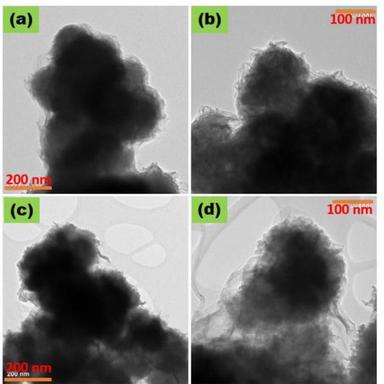
TEM images of (a), (b) ZnO/NiS and (e), (f) of ZnO/NiS/CNT on a nickel foam substrate.